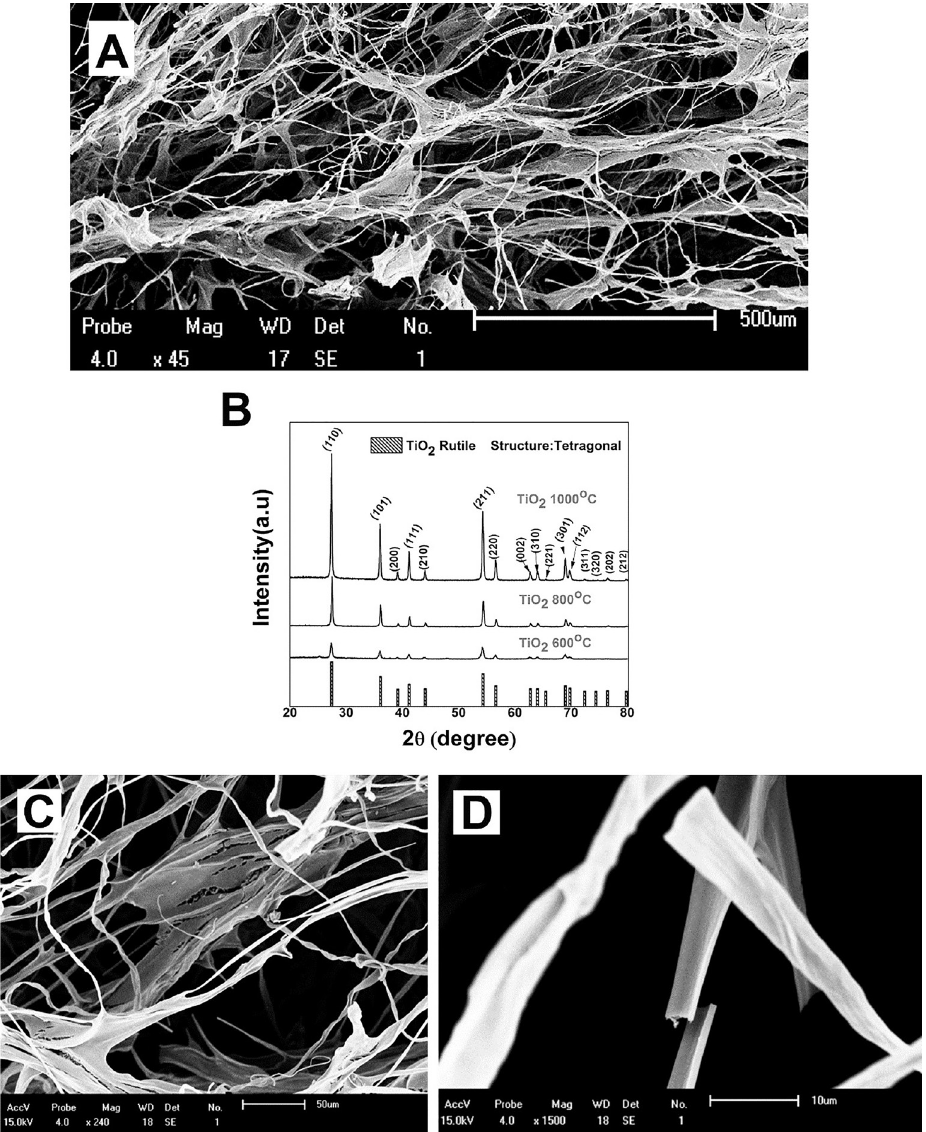
membrane at 600 °C and (B) XRD pattern of TiO 2 at different heat treatment 2